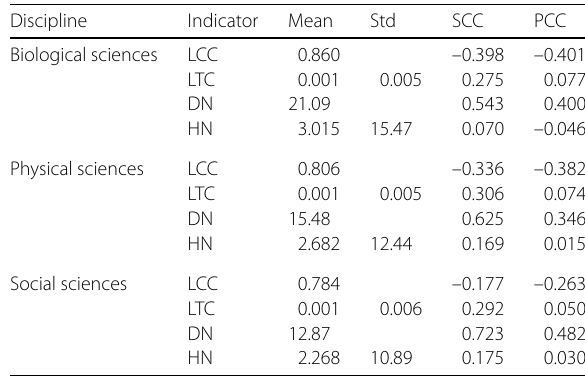
Table 5 Correlation coefficients between degree and transitivity/clustering indexes Discipline Indicator Mean Std SCC PCC Biological